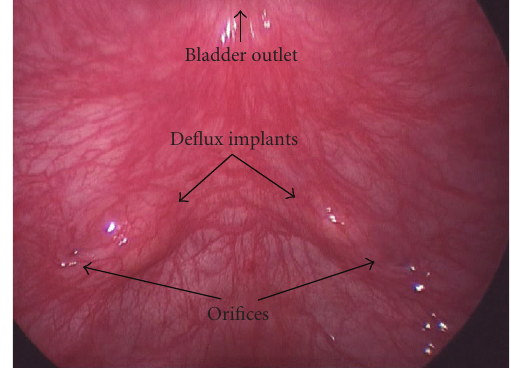
Figure 3: Initial “vesicoscopic” view of operative site in a patient that had failed prior injection